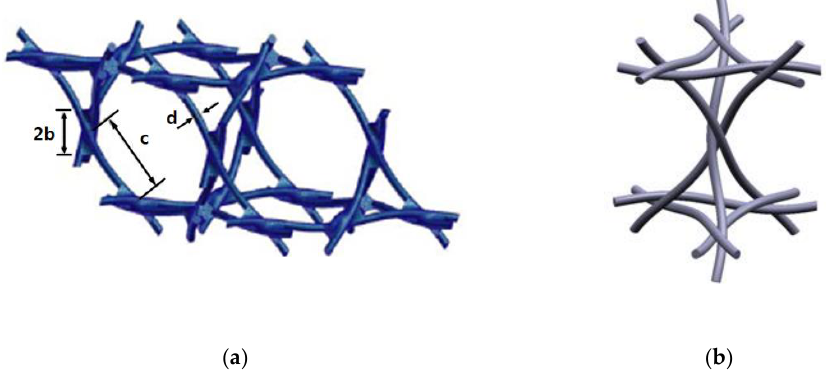
Figure 2. Shape of the Kagome damper unit cell [28]. ( a ) Unit cell, ( b ) Tetrahedron.